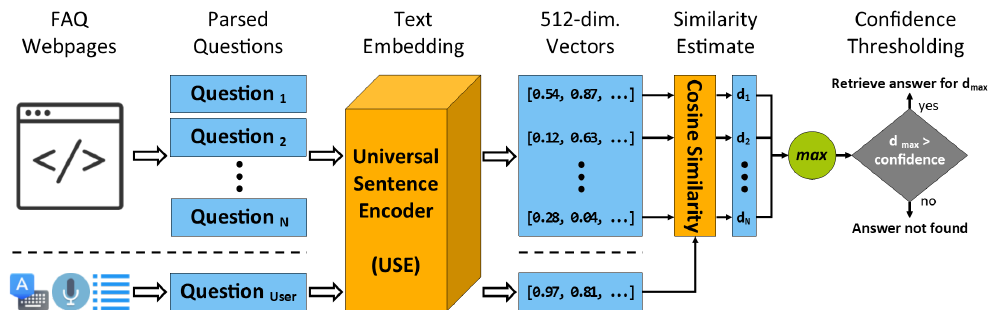
Figure 2. Flowchart summarizing the Q&A Mode’s execution